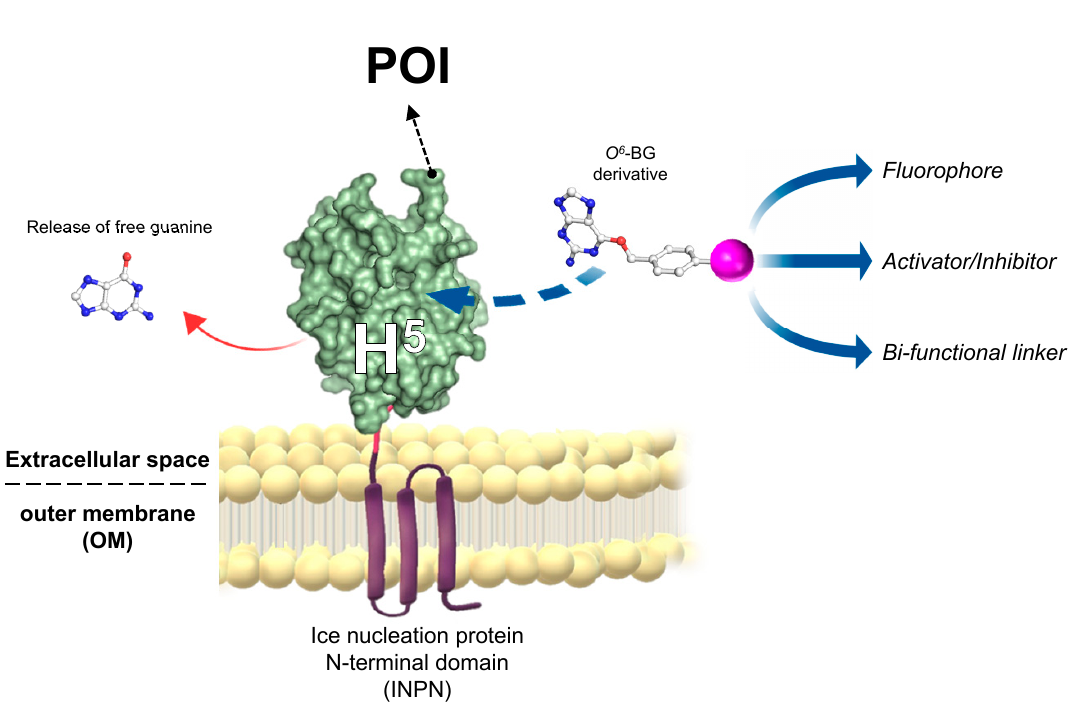
Figure 5. The novel anchoring and self-labelling protein tag (ASL tag ) system. A protein of interest (POI) is genetically encoded with the tag , which in turn makes it anchored in the outer membrane and accessible for the covalent linkage to a desired chemical group (magenta sphere) by the activity of Ss OGT-H 5 (adapted from